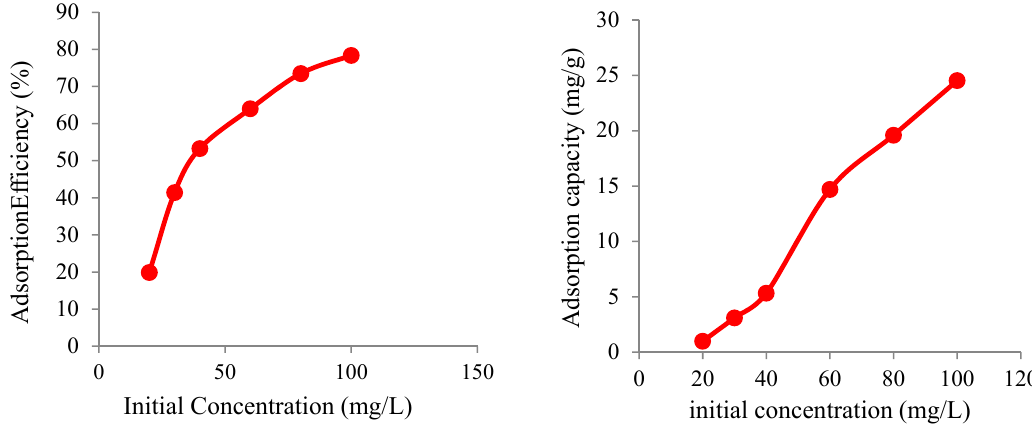
Fig. 8: Effect of initial concentration on the adsorption efficiency and